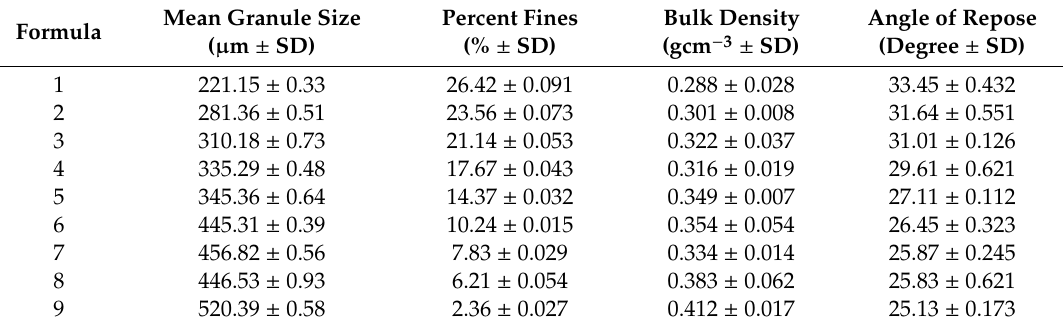
Table 6. Physical characteristics of prepared granules of 3 2 full factorial design (mean ± SD).